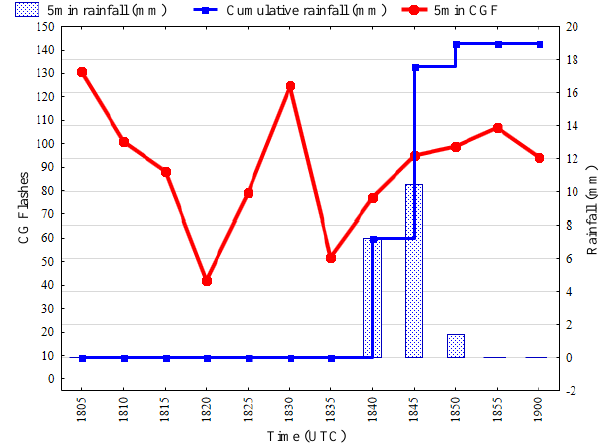
Figure 11. Critical interval time series for debris flow event of 30 June 2001. This is an event from the STH group and debris flow initiation was observed at